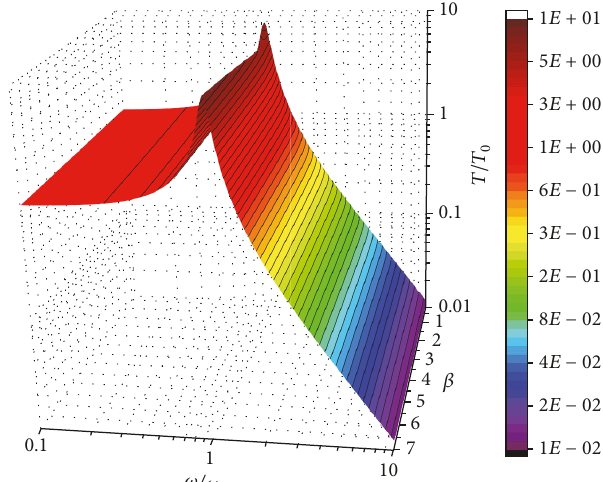
Figure 47: Transmissibility surface ( 𝛼 = 1.2, 𝛽 = 0.2–7).